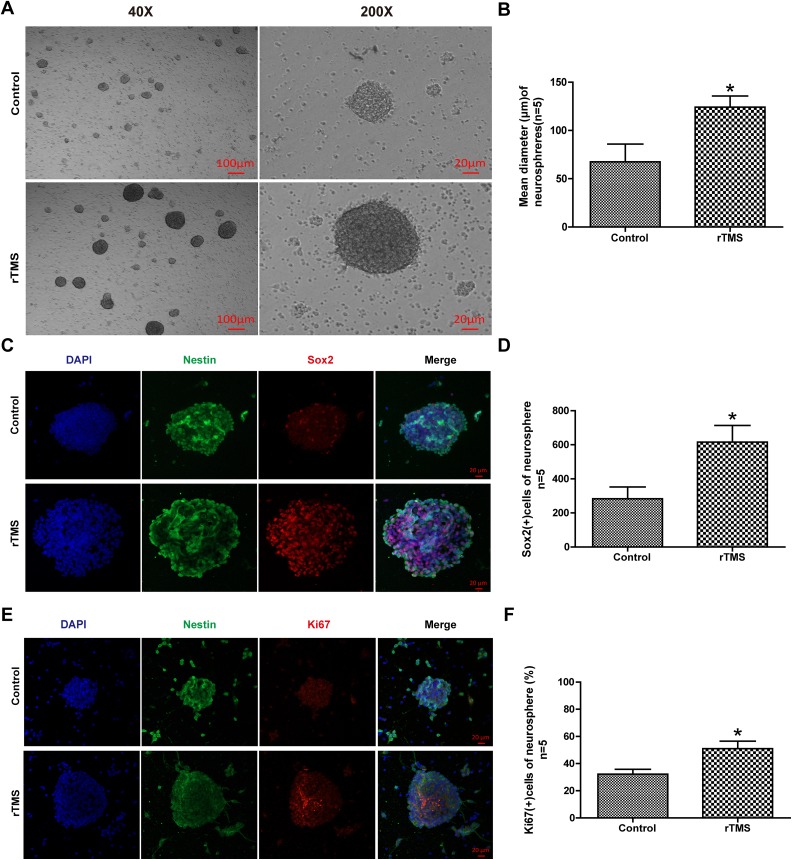
The effects of rTMS on the proliferation of NSCs in vitro. (A) Representative
photographs of light microscopy and quantitative analyses of (B) mean diameter of
neurospheres in the control and rTMS groups. (C) Representative photographs of
immunofluorescence co-staining of NSCs for DAPI (blue), Nestin (green), and Ki-67
(red) in the control and rTMS groups. Quantitative analyses of (D) Ki-67-positive
cells and E: Sox2-positive cells in neurospheres in the control and rTMS groups.
n = 5 for mean diameter analysis, n = 5 for
immunofluorescence staining analysis. Scale bar = 20 μm; *p < 0.05
vs. control.